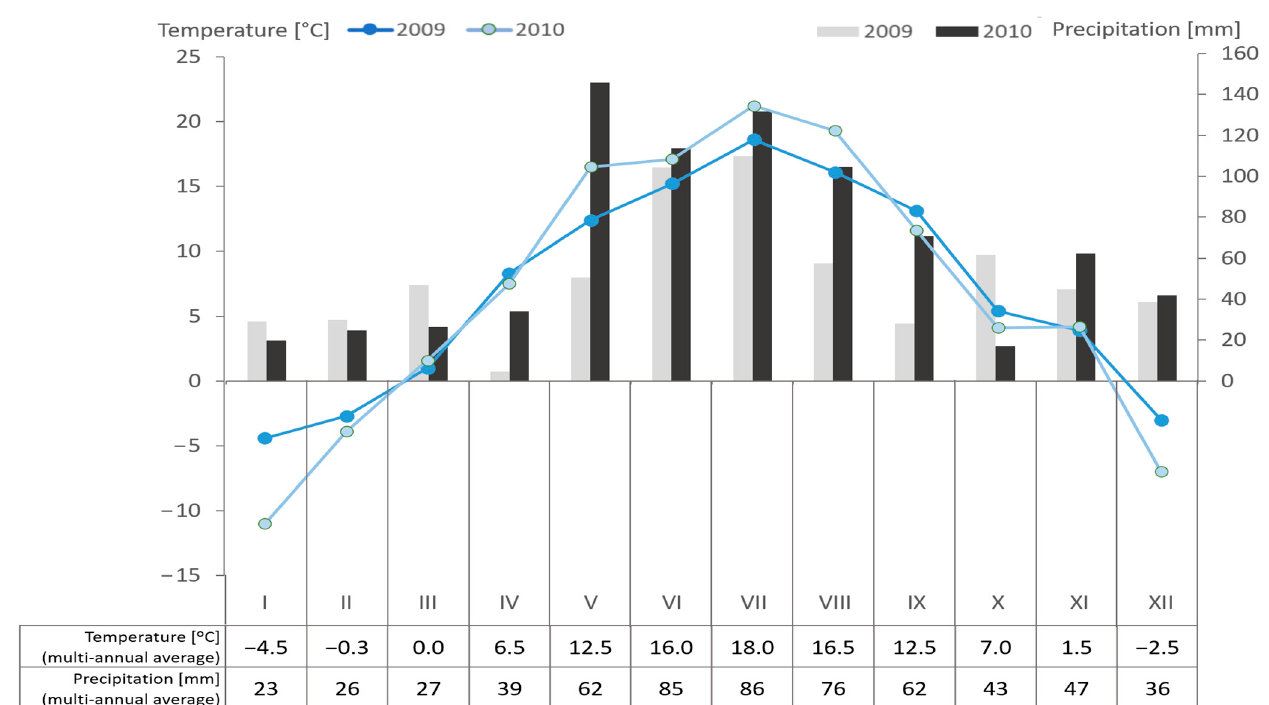
Figure 2. Monthly temperature and sum of precipitation in the years 2009–2010 and multi-annual averages (data 2009–2010 from Experimental Department in Biebrza Institute of Technology and Life Science; data 1962–1994: temperature from [24], precipitation from [27]) .